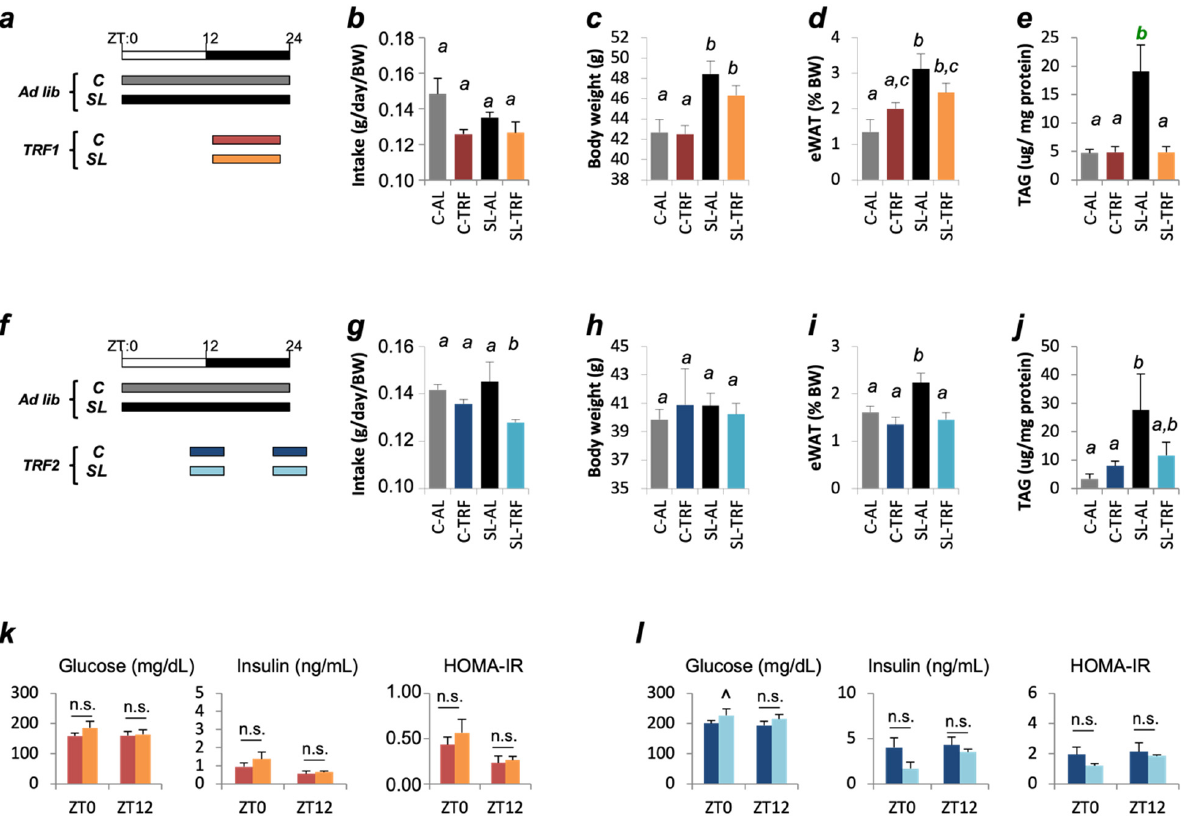
Figure 2. Two independent time restricted feeding (TRF) procedures ameliorated hepatic steatosis in small litter (SL) mice. (A) Scheme, representing the feeding-fasting distribution of C-TRF1 and SL-TRF1 mice during the day. The white bar represents the light cycle and the black one the dark cycle. ZT is the Zeitgeber Time. ZT0 corresponds to the beginning of the light cycle and ZT12, the beginning of the dark cycle. (B) Average food intake of C-AL ( n = 10 ), SL-AL ( n = 10 ), C-TRF1 ( n = 5 ) and SL-TRF1( n = 5 ) during the 4-week intervention period. (C) Body weight, (D) epididymal fat mass and (E) hepatic TAG content of C-AL, SL-AL, C-TRF1 and SL-TRF1 mice. (F) Scheme, representing the feeding-fasting distribution of C-TRF2 and SL-TRF2 mice across the 24-hour cycle of one day. (G) Average food intake, (H) body weight, (i) epididymal fat mass and (J) hepatic TAG content of C-AL ( n ≥ 5 ), SL-AL ( n ≥ 5 ), C-TRF2 ( n ≥ 5 ) and SL-TRF2 ( n ≥ 5 ) mice. (K) Plasma glucose and insulin levels in C-TRF1and SL-TRF1 mice, at the end of the 4-weeks intervention. Insulin sensitivity was assessed through Homeostasis Model Assessment of Insulin Resistance, HOMA-IR. (L) Plasma glucose and insulin levels, and (HOMA-IR) in C-TRF2 and SL-TRF2, at the end of the 4-weeks intervention. All three measurements were taken at two independent times of the 24-hour cycle, ZT0 ( n ≥ 5 both, C and SL) and ZT12 ( n ≥ 5 both, C and SL). Data represent means ± S.E.M. ^ p < 0.1 versus Control mice, Student’s t Test; a p < 0.05 versus b or c, ANOVA; b p < 0.05 versus a or c, ANOVA; c p < 0.05 versus a or b , ANOVA. n.s. not significant.